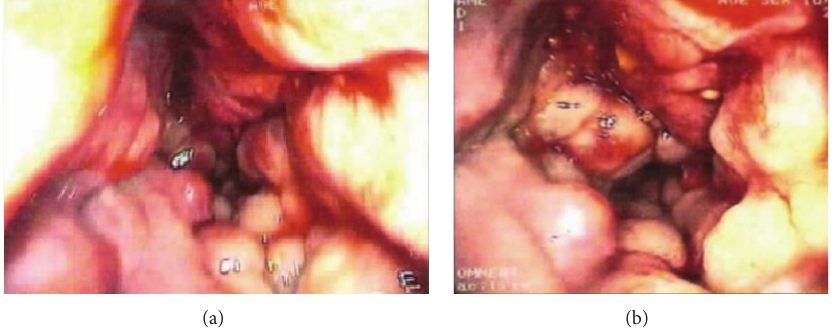
Figure 2: Colonoscopic findings. Diffuse blue-purple variceal enlargements on the rectal mucosa (hemangioma) and a polyp in the rectum with a diameter of 1cm (a). The rectal mucosa was bluish purple from the 10thcm to 20thcm (hemangioma) (b).